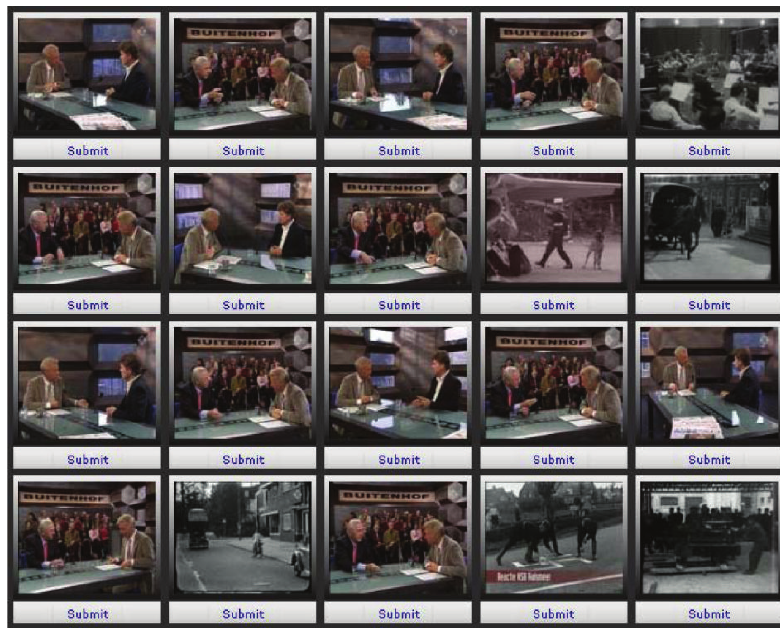
Figure 18: Combined ranking of results for the query shot on the top left corner.